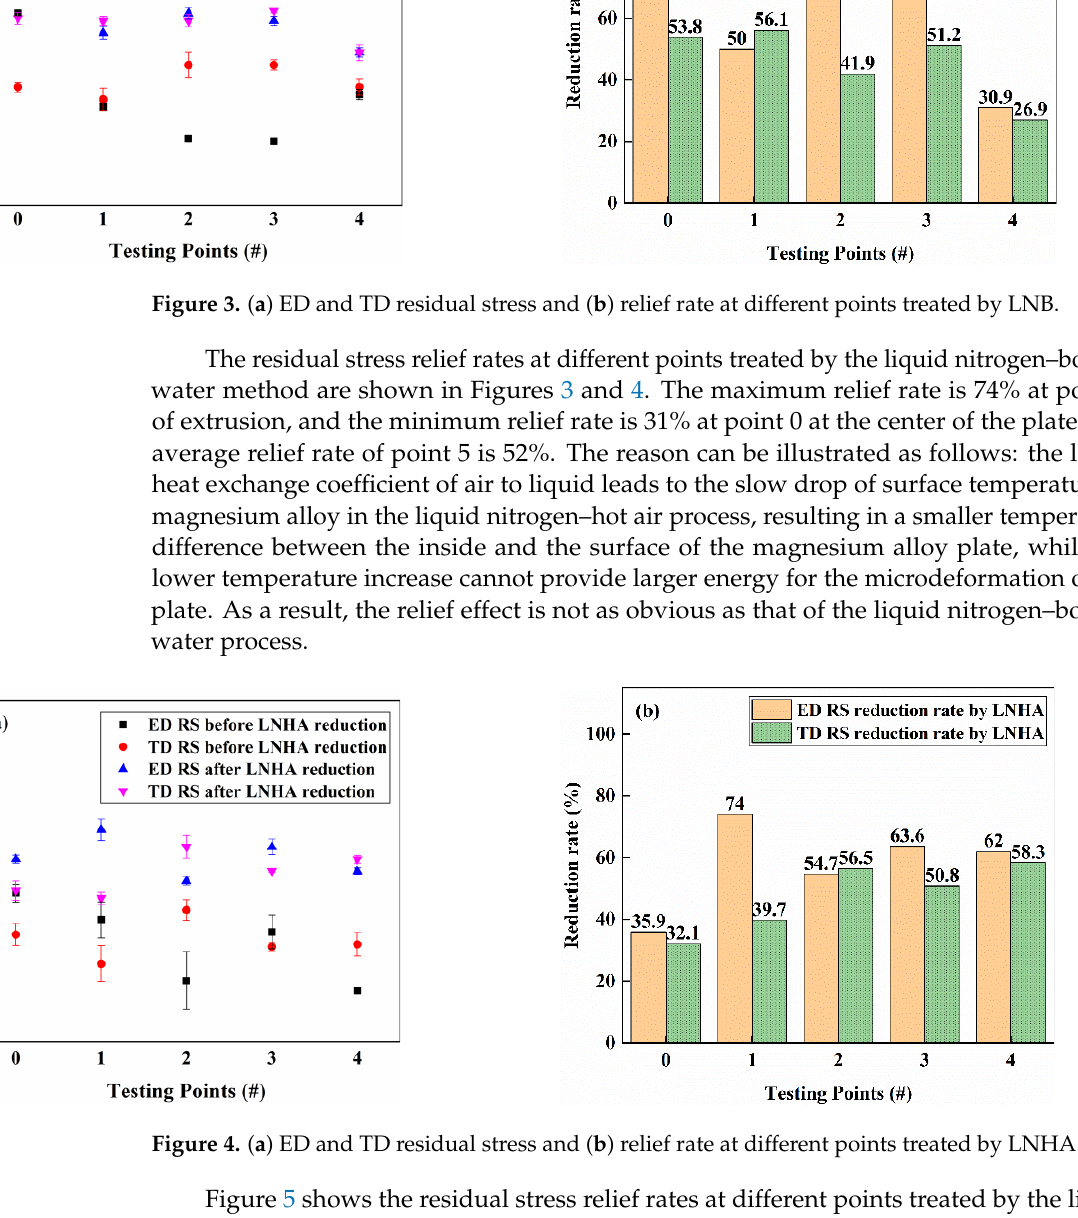
Figure 4. ( a ) ED and TD residual stress and ( b ) relief rate at different points treated by